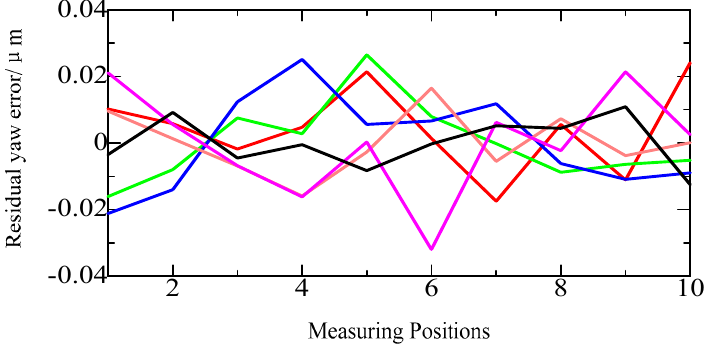
Figure 15. The residual yaw error of six cross-sectional profiles.